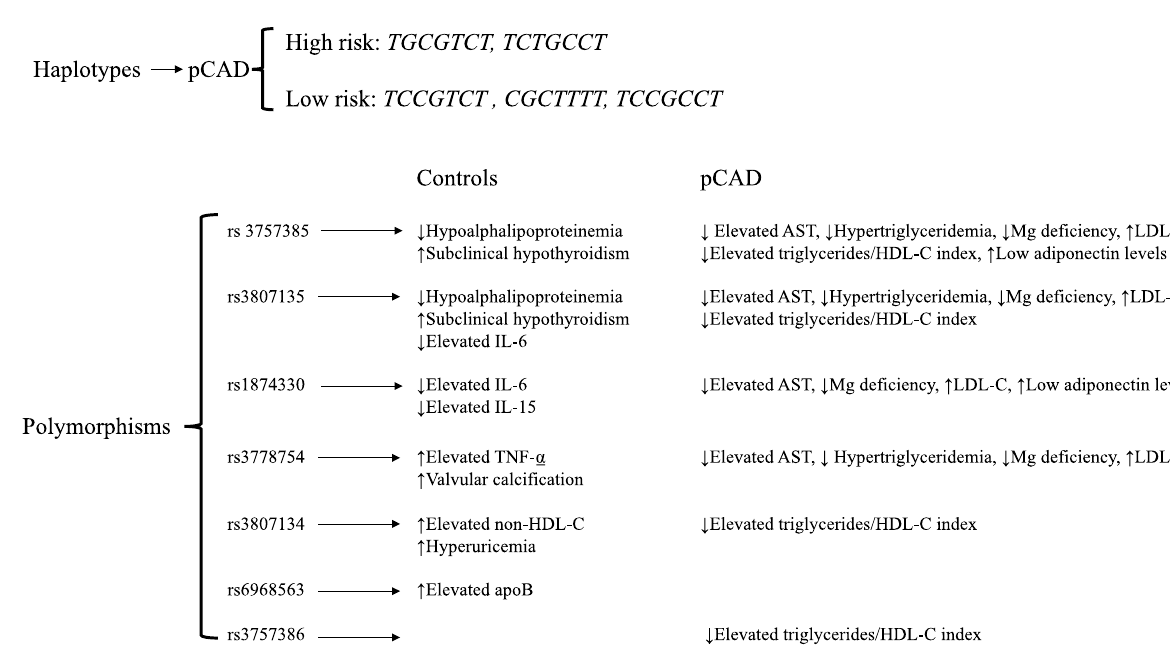
Figure 2. Association of IRF5 polymorphisms with cardiometabolic parameters in pCAD patients. All models were adjusted by age, sex, and BMI. Dom: dominant model; Rec: recessive model; Codom1: codominant 1 model; Codom2: codominant 2 model; Het: heterozygote model. OR (95% CI) p values.